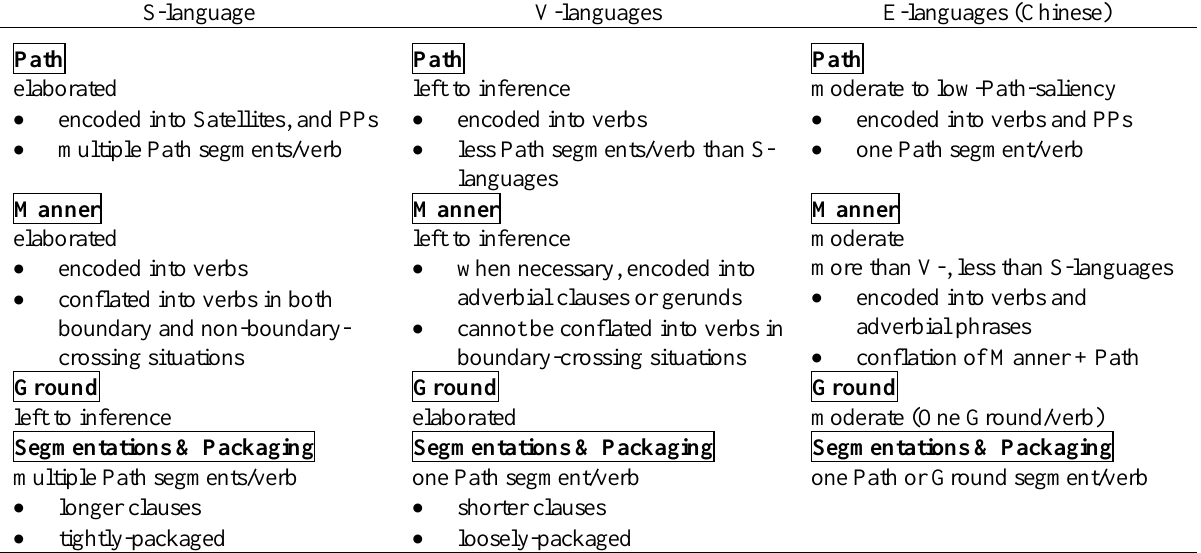
Summary of Suggested Characteristics of S- and